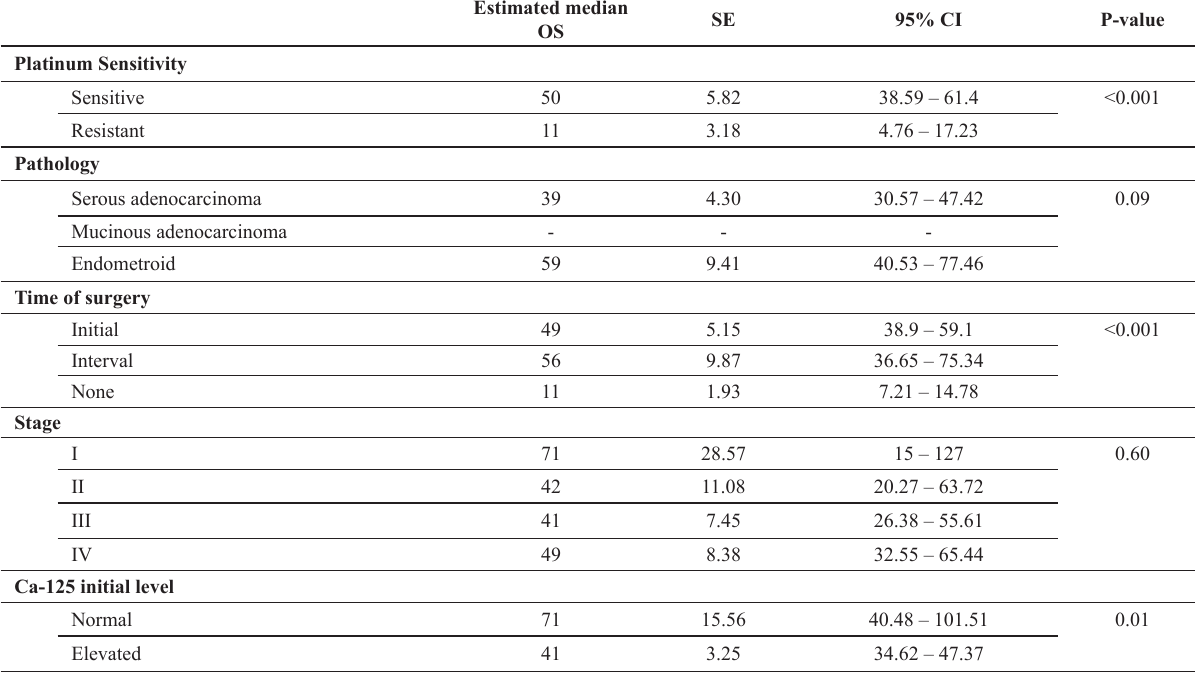
table 5: Overall survival (OS) according to different risk factors.